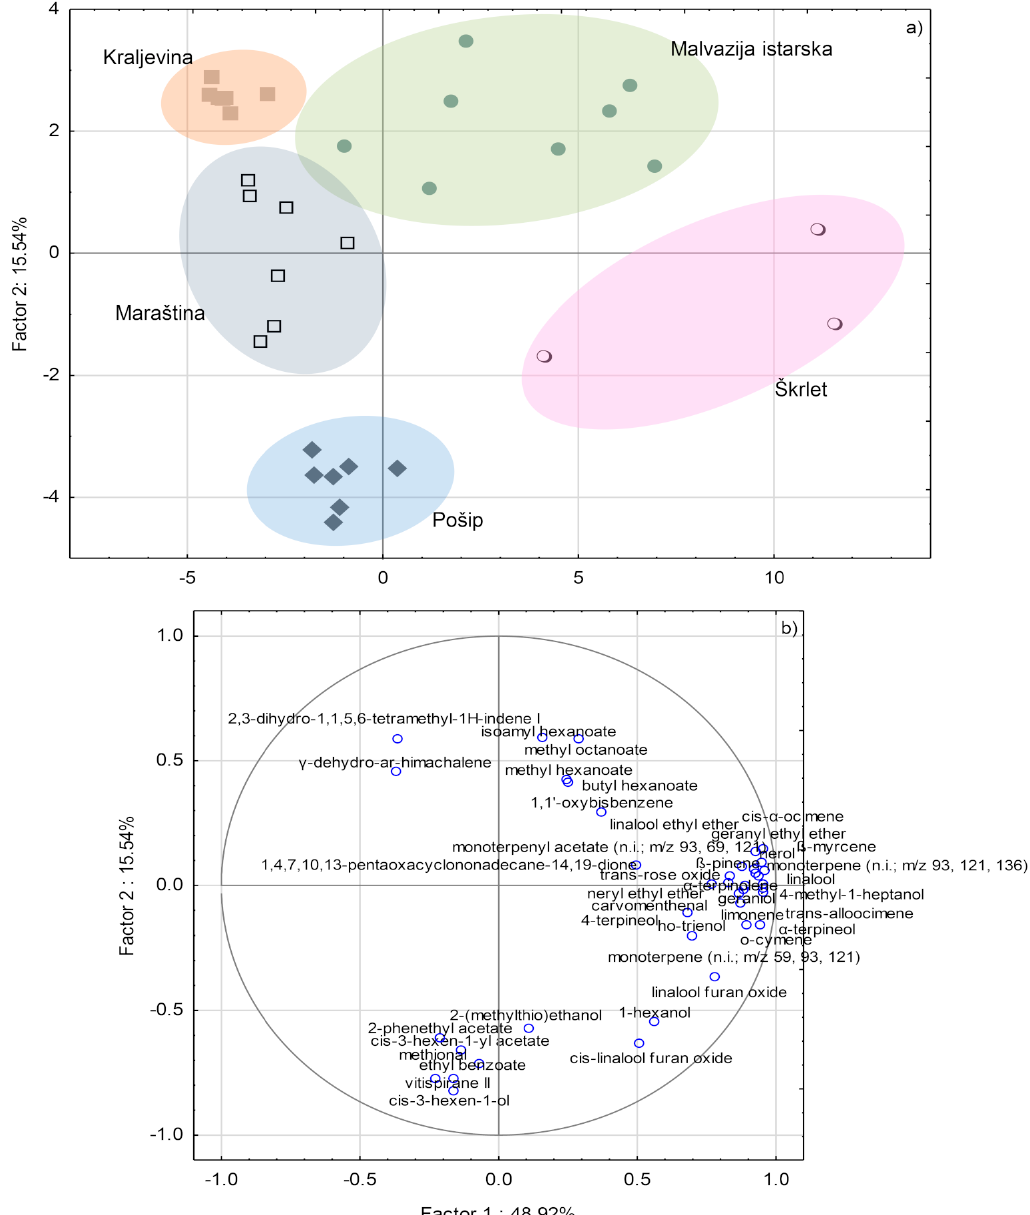
Figure 1. ( a ) Separation of Croatian monovarietal wines according to variety in two-dimensional space defined by the first two principal components, PC1 and PC2; ( b ) Factor loadings of selected variables (40 volatile aroma compounds with the highest F -ratios), as determined by gas chromatography mass spectrometry (GC-MS) and two-dimensional gas chromatography with time-of-flight mass spectrometry (GC × GC-TOF-MS) analysis, on PC1 and PC2. SLDA was applied on a dataset reduced to 60 most significant volatile aroma compounds according to F -ratio from both GC-MS and GC×GC-TOF-MS original datasets. All the monovarietal wines were classified correctly according to variety by this model, and 24 most significant variables were extracted (Figure 3), with rather high squared Mahalanobis distances from group centroids. A 100% correct classification was obtained after including only seven variables. α -Terpineol was confirmed once again as the most powerful varietal marker, since the SLDA model classified correctly 68.75% of all the wines and 100.00% of Škrlet wines by using only this variable. After